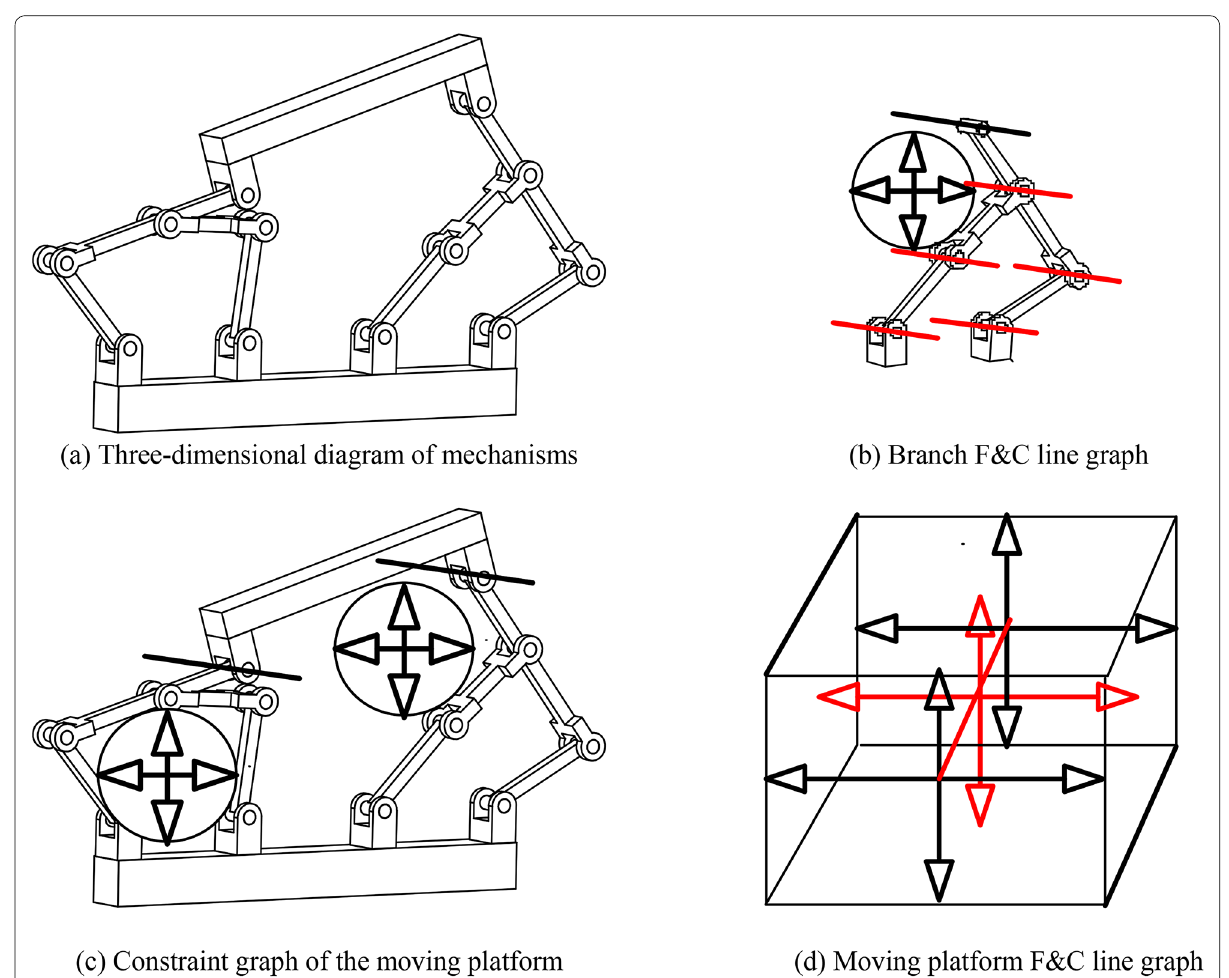
Figure 20 Correlated line diagram at initial